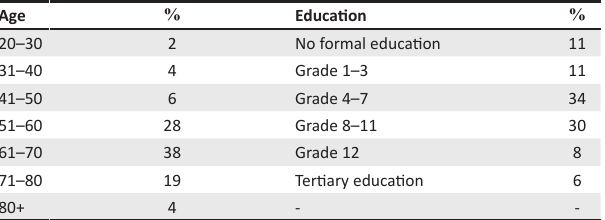
TABLE 1a: Demographic information of participants ( n = 53). (Percentages have been rounded).